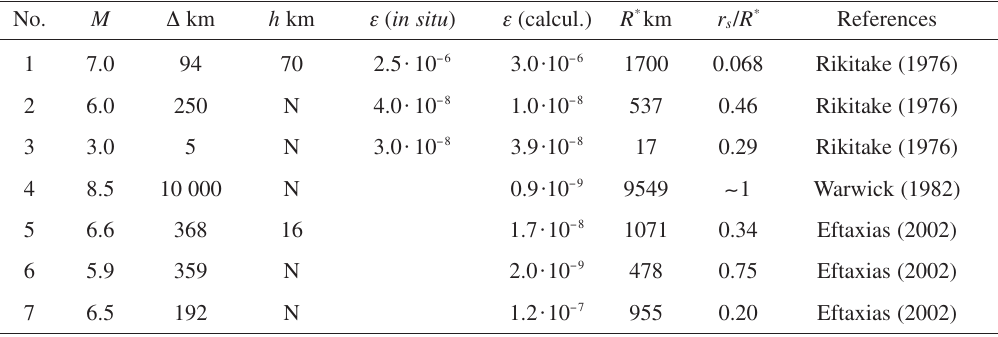
Table II. Examples of calculated values ε s , R * , and r s / R * in comparison with parameters of some earthquakes that were preceded by precursory variations. No. M ∆ km h km ε ( in situ ) ε (calcul.) R *